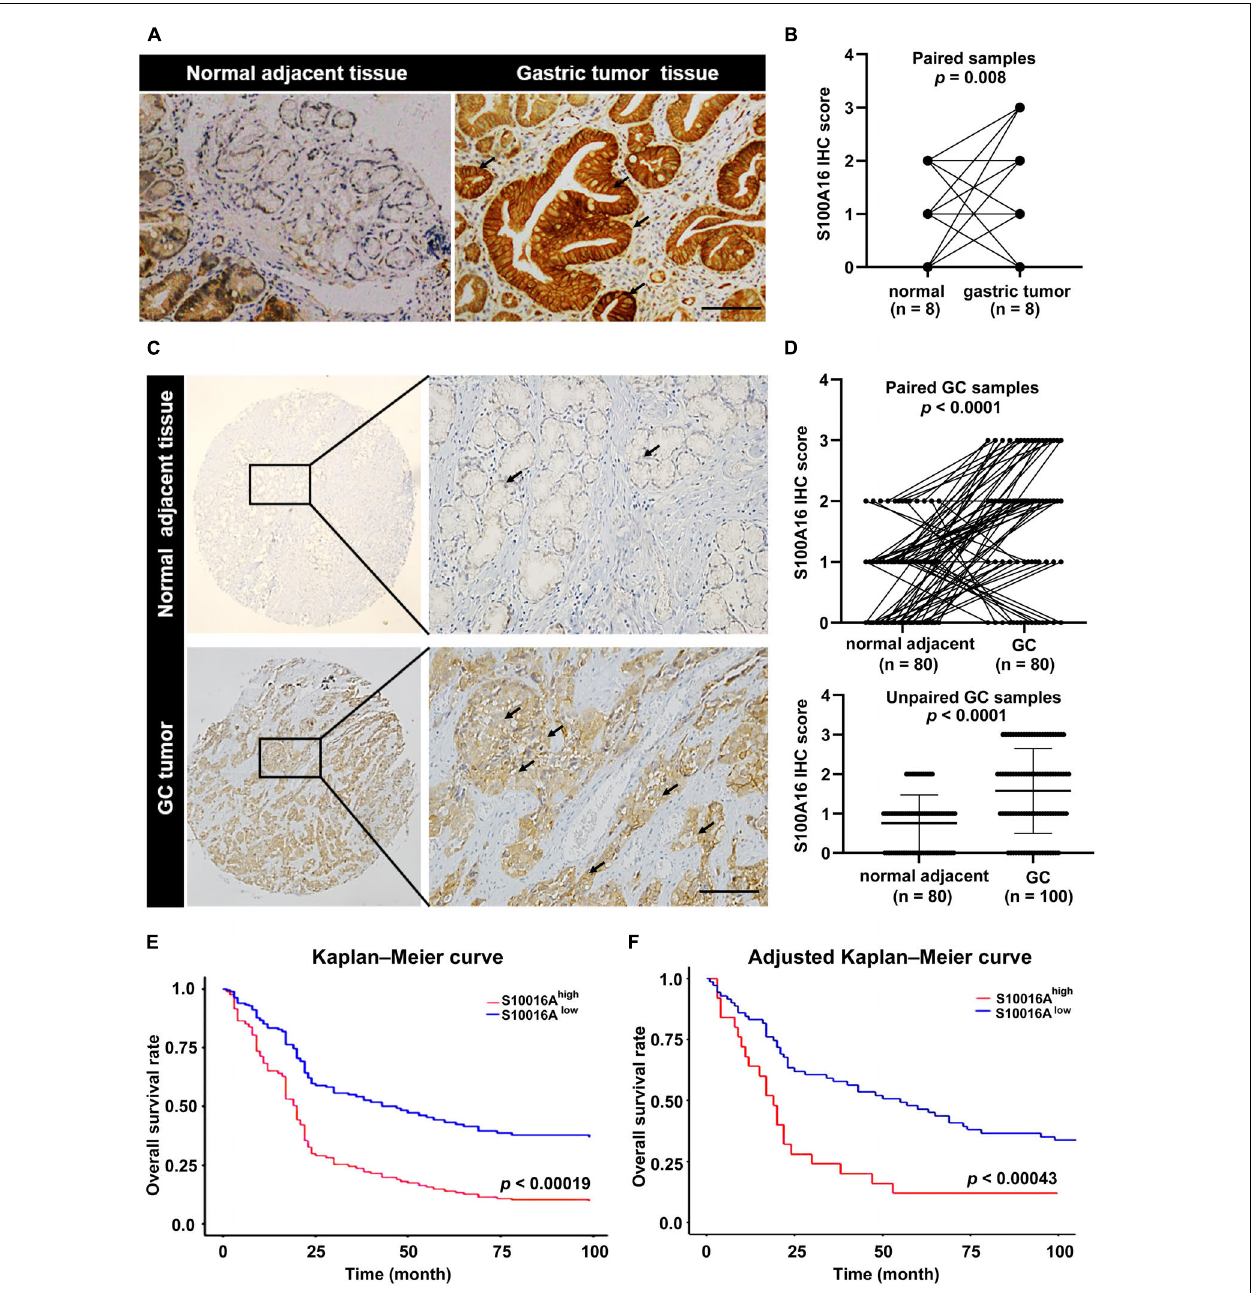
FIGURE 2 | S100A16 is upregulated in GC tissues and correlated with poor prognosis in GC patients. (A) IHC staining of S100A16 in gastric tumors compared with normal adjacent tissues obtained from the Department of Pathology in Sir Run-Run Hospital of Nanjing Medical University. Scare bar = 200 µ m. (B) Quantification of immunohistochemical staining in paired gastric samples ( n = 8). (C) IHC staining of S100A16 in GC tissues compared with normal adjacent tissues, both of which obtained from purchased tissue microarray. Scare bar = 200 µ m. (D) Paired line plots showing S100A16 IHC score in matched gastric cancer tissues ( n = 80, upper). Unpaired line plots showing S100A16 IHC score in gastric cancer tissues [normal adjacent tissues ( n = 80) GC tissues ( n = 100), lower]. (E) Kaplan–Meier survival analysis of S100A16 high and S100A16 low GC patients mentioned in panel (C) . (F) Adjusted Kaplan-Meier curves of overall survival rate in panel (E)